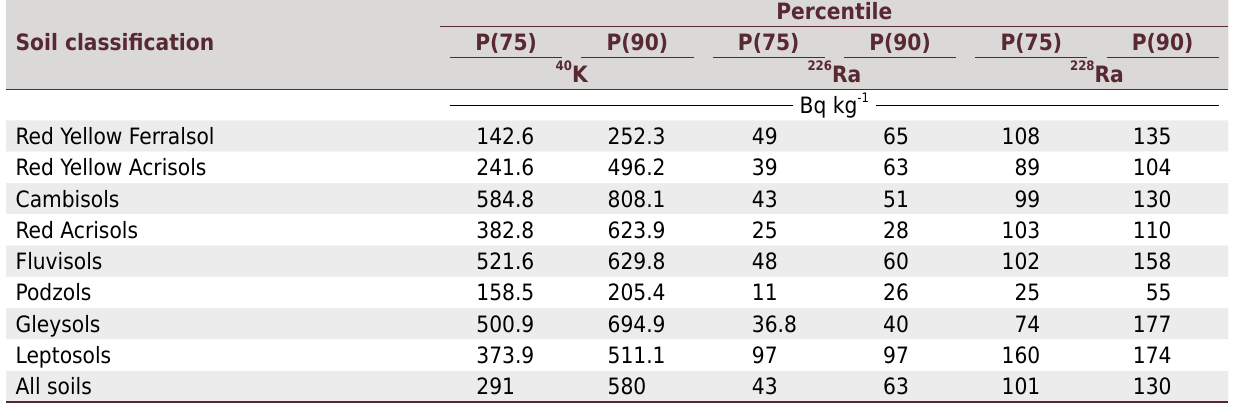
Table 8. Quality Reference Values of 40 K, 226 Ra, and 228 Ra for each soil class Soil